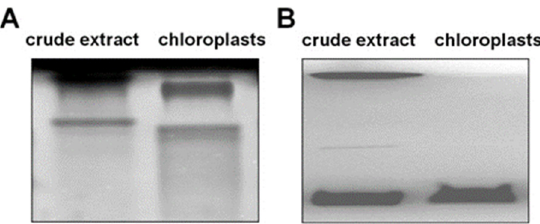
Figure 9. Representative gels of amylolytic ( A ) inverted picture and glucan phosphorylase ( B ) ac-